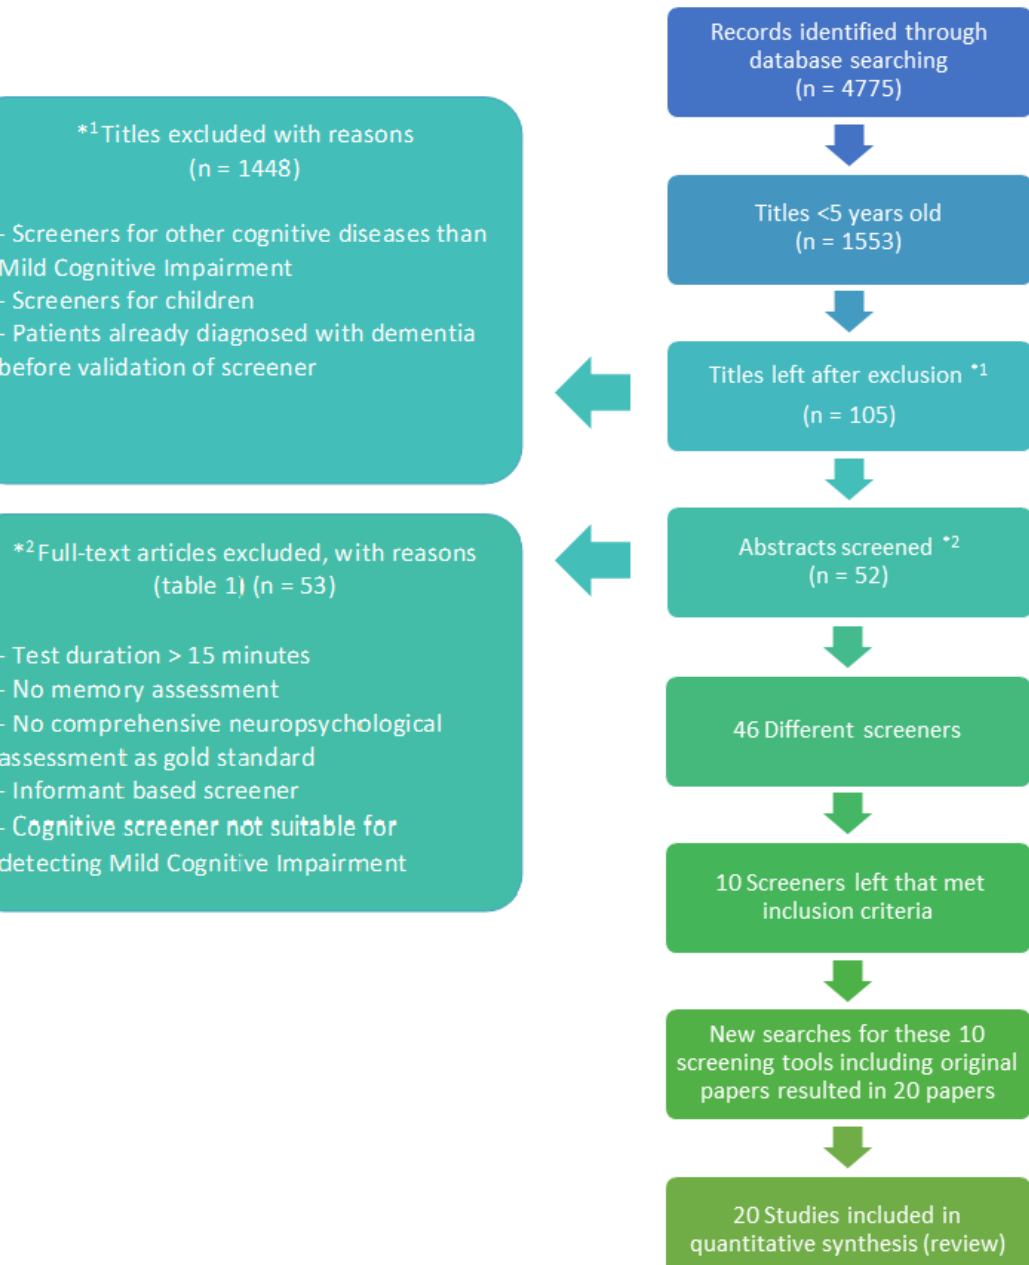
Figure 1. Flowchart showing the search strategy and article/screener selection after the literature and snowball search.